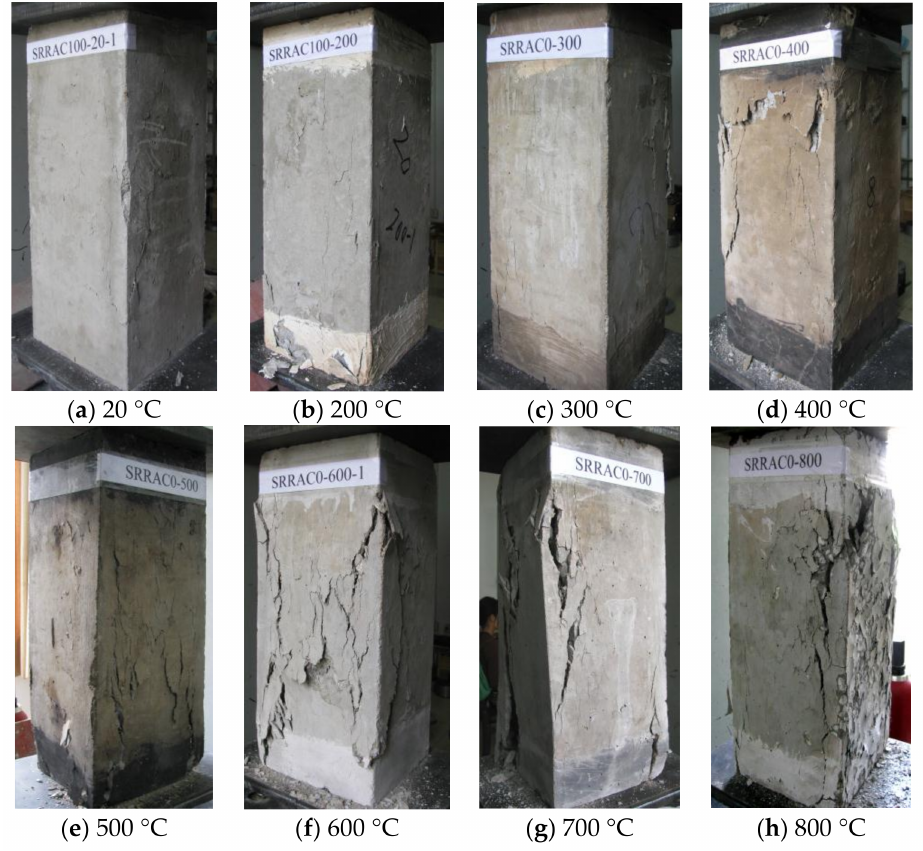
Figure 8. The failure modes of column